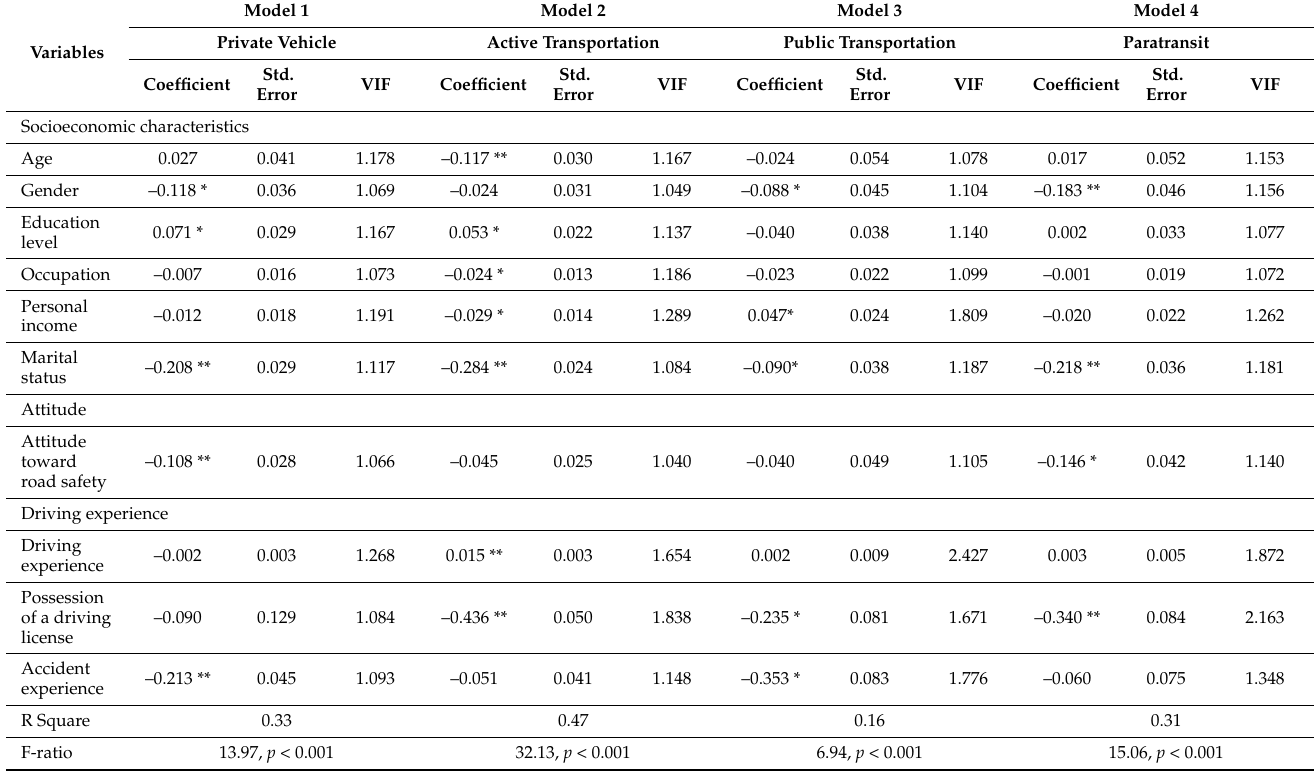
Table 4. Factors affecting risk behavior on different travel